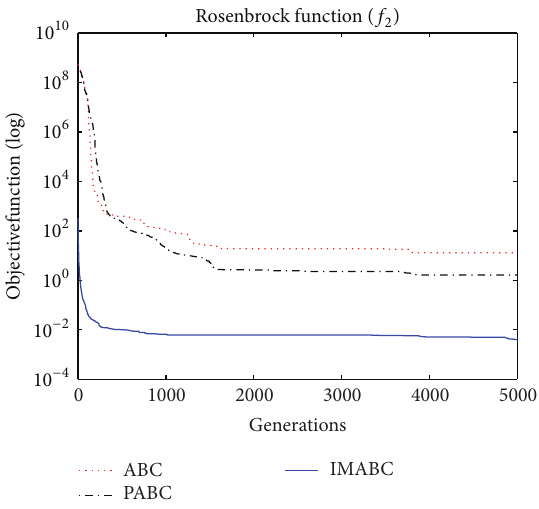
Figure 4: 𝑓 2 function convergence performance